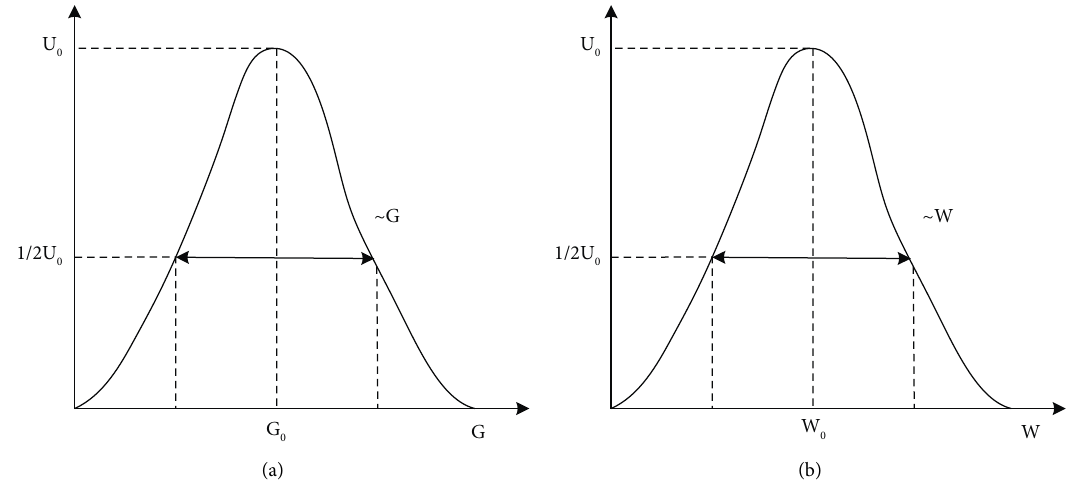
Figure 2: Two typical ferromagnetic resonance